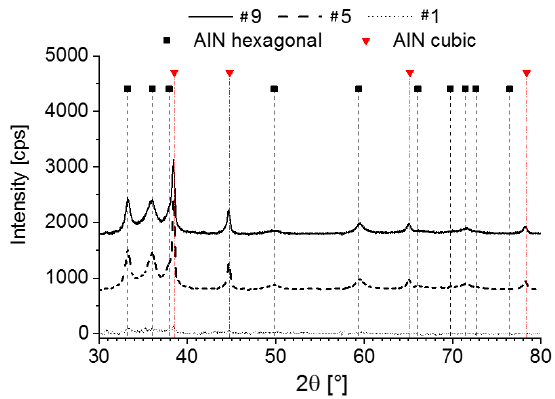
Figure 3. X-ray diffraction (XRD) patterns of layers deposited in pure argon atmosphere on low temperature co-fired ceramic (LTCC).